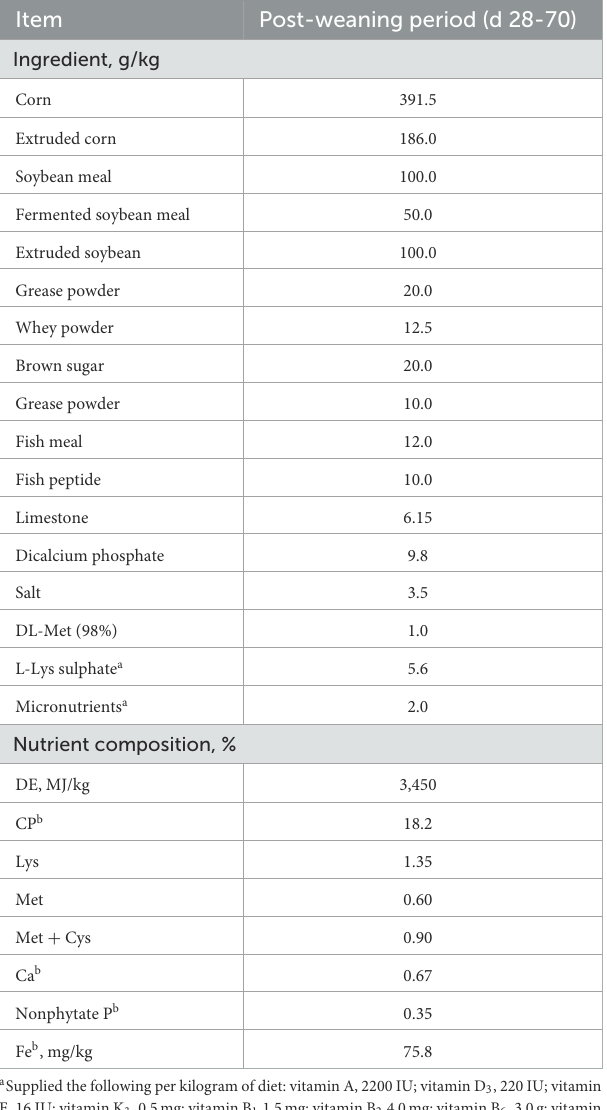
Table 2. The relative gene expression was quantified by normalizing to the mRNA expression of β -actin as per the 2 − 11 Ct method